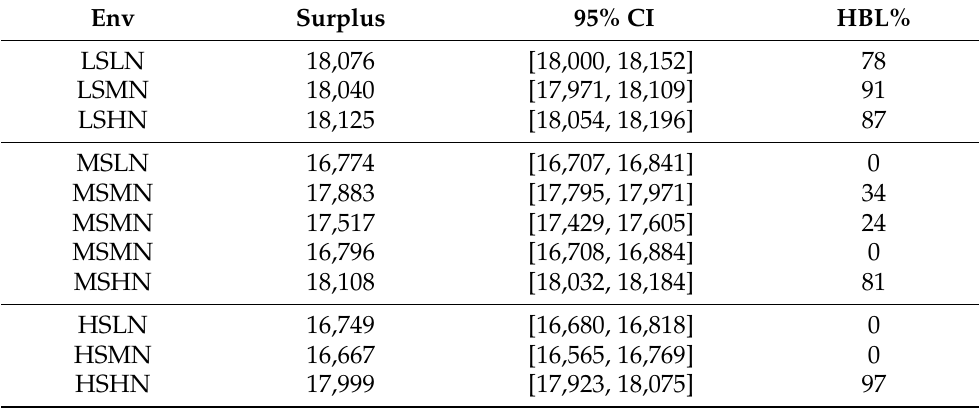
Table A3. Background-trader surplus and HBL proportion in equilibrium of markets with spoofing. Each row describes one Nash equilibrium found in a game (rounded to the nearest integer). N = 28 with spoofing.